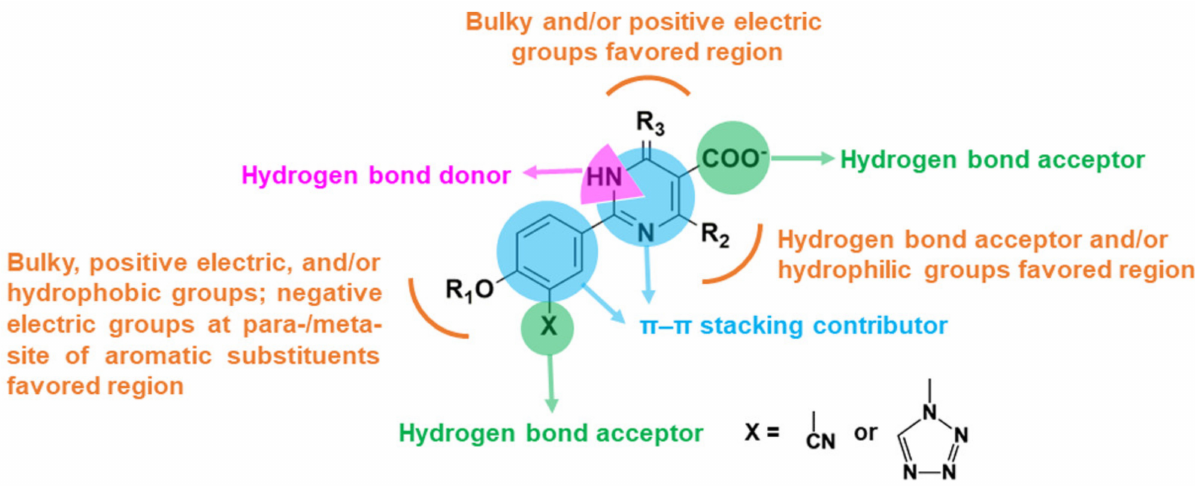
Figure 8. The SARs of 1,6-dihydropyrimidine-5-carboxylic acid XOIs based on the 3D-QSAR models, molecular docking results, and the pharmacophore